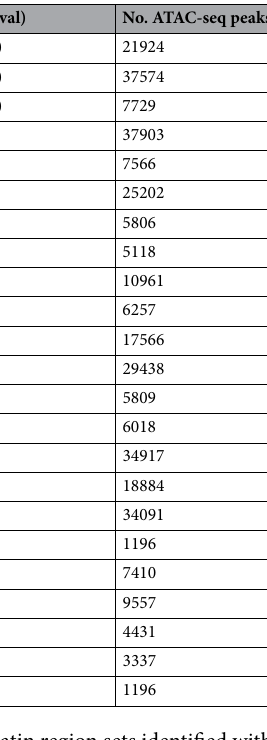
is marked with a star and is reported in the text as significantly enriched with PD risk variants. We adjusted for multiple testing by Bonferroni correction, adjusting for 23 tests. Unadjusted p-values are provided